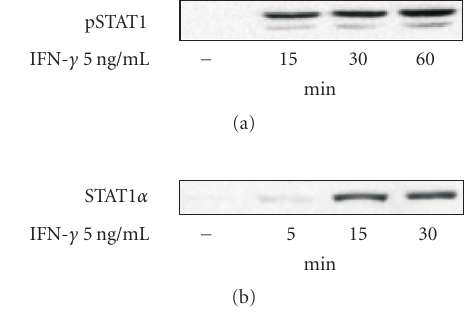
Figure 1: (a) Time-dependent activation (Tyr701 phosphorylation) of signal transducer and activator of transcription 1 (STAT1) by interferon- γ (IFN- γ ) in J774 macrophages. Cells were treated with IFN- γ (5ng/mL) for di ff erent times as indicated. Proteins were ex- tracted with modified RIPA-bu ff er, and the protein contents were measured. Equal amounts of lysates (20 μ g protein) were subjected to immunoblot analysis with antibody specific for STAT1 phospho- rylated at the tyrosine residue 701. Similar results were obtained in three independent experiments. (b) Time-dependent nuclear translocation of STAT1 α in IFN- γ -stimulated J774 macrophages. Cells were treated with IFN- γ (5ng/mL) for di ff erent times as in- dicated. The nuclear proteins were extracted as described in mate- rials and methods. The protein content of the samples was mea- sured, and equal amounts of proteins (20 μ g) were subjected to im- munoblot analysis with antibody against STAT1 α . Similar results were obtained in two independent